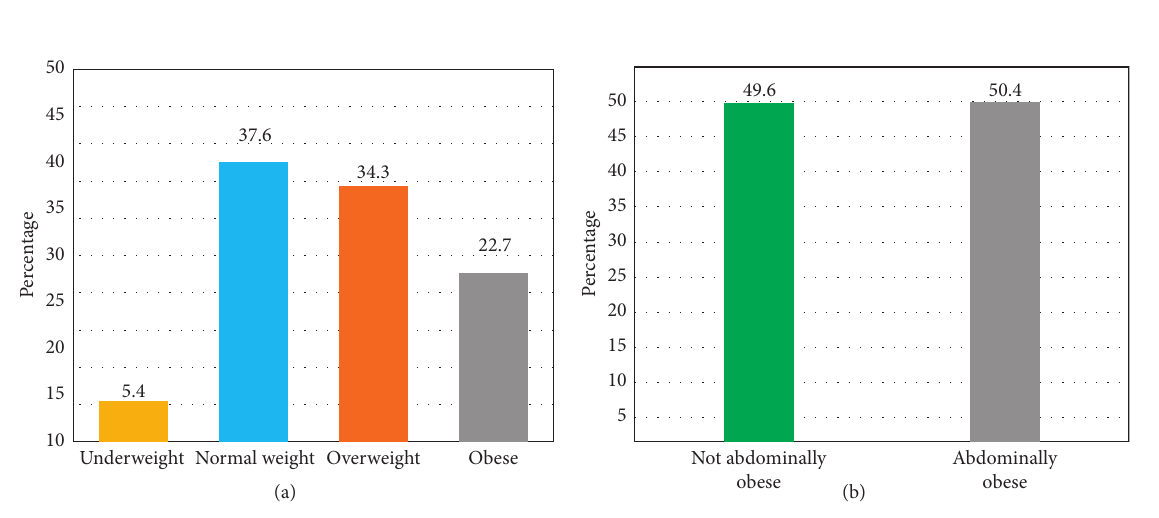
Figure 1: Prevalence of overall obesity, overweight (a), and abdominal obesity (b) among the study population. (a) BMI groups. (b) WHR groups.